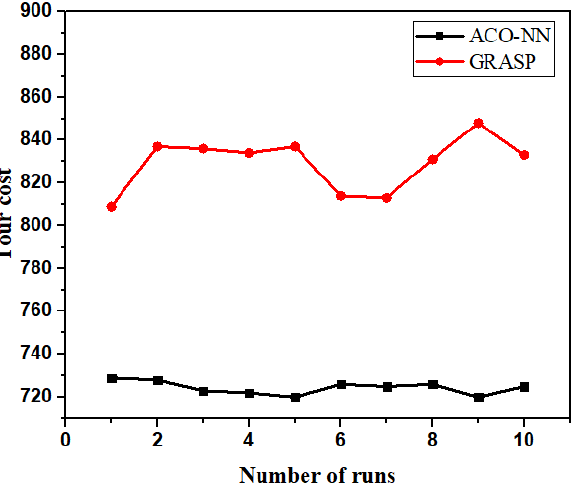
Figure 8. Comparison of ACO-NN with GRASP for St70 regarding optimal solution metric.